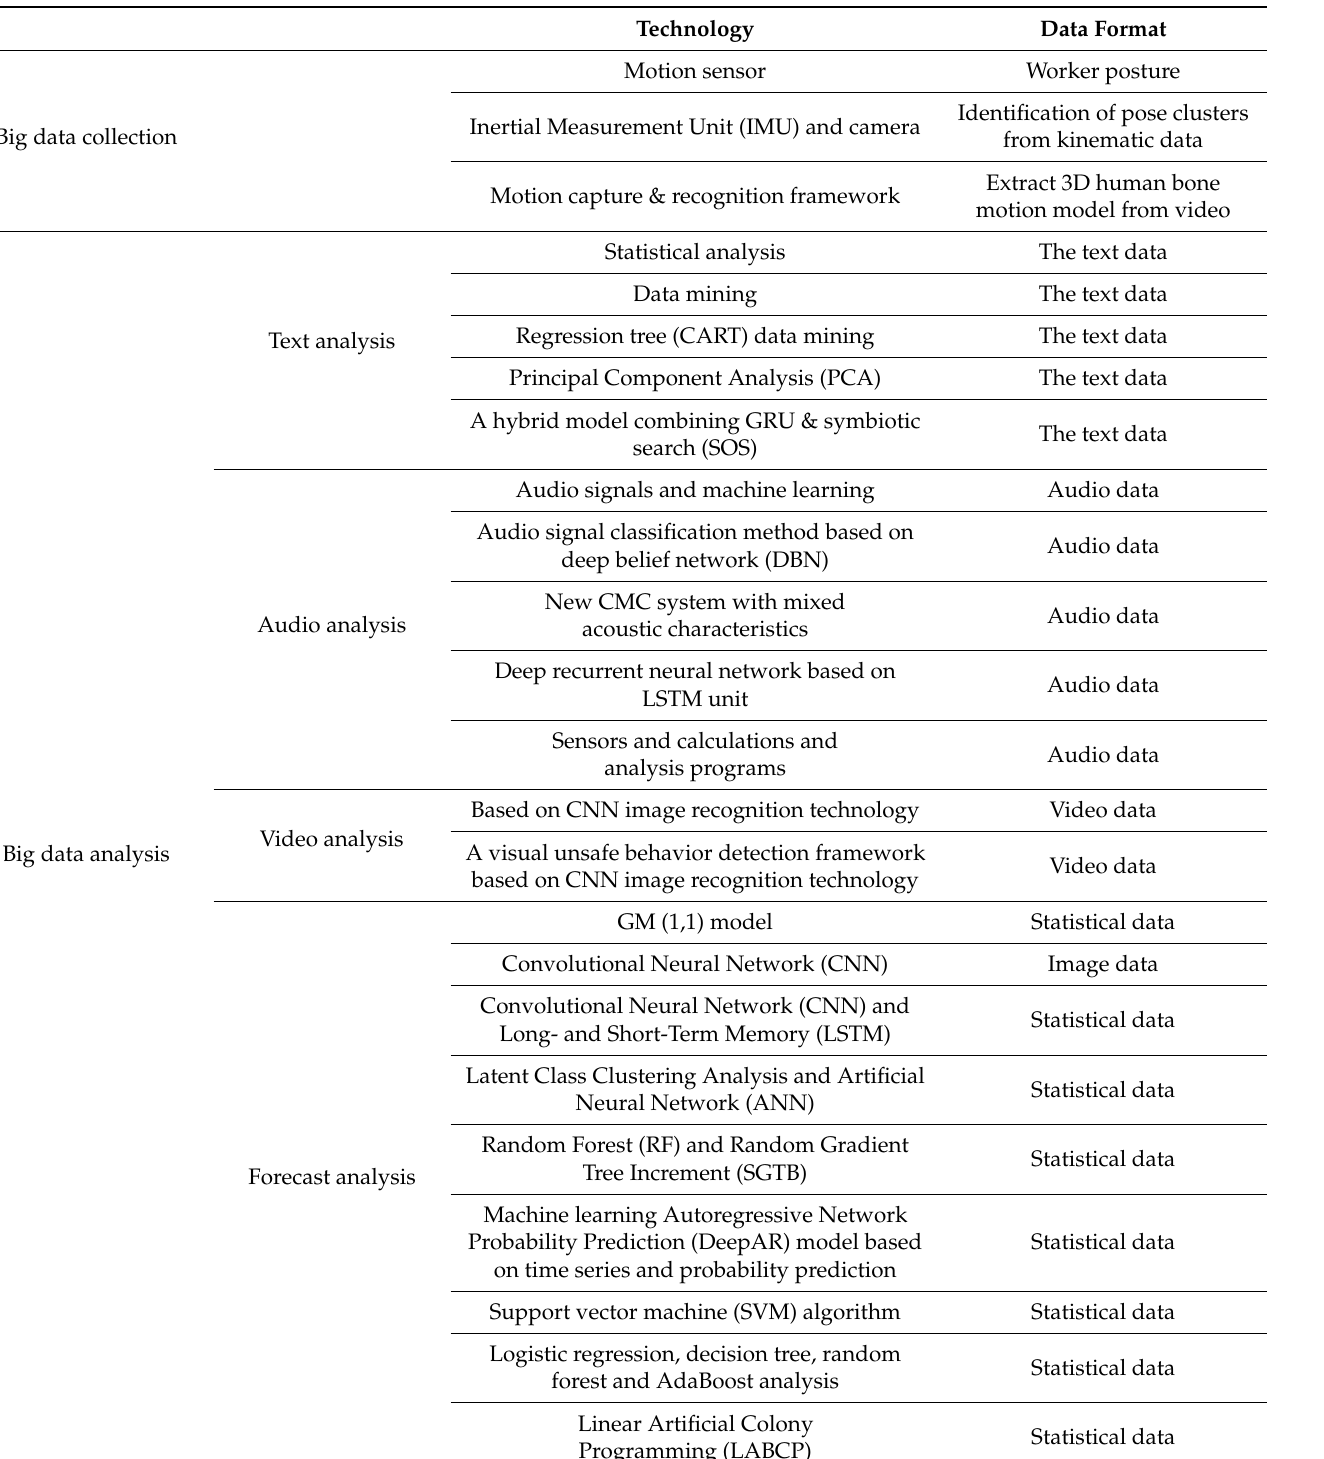
Table 3. Technical